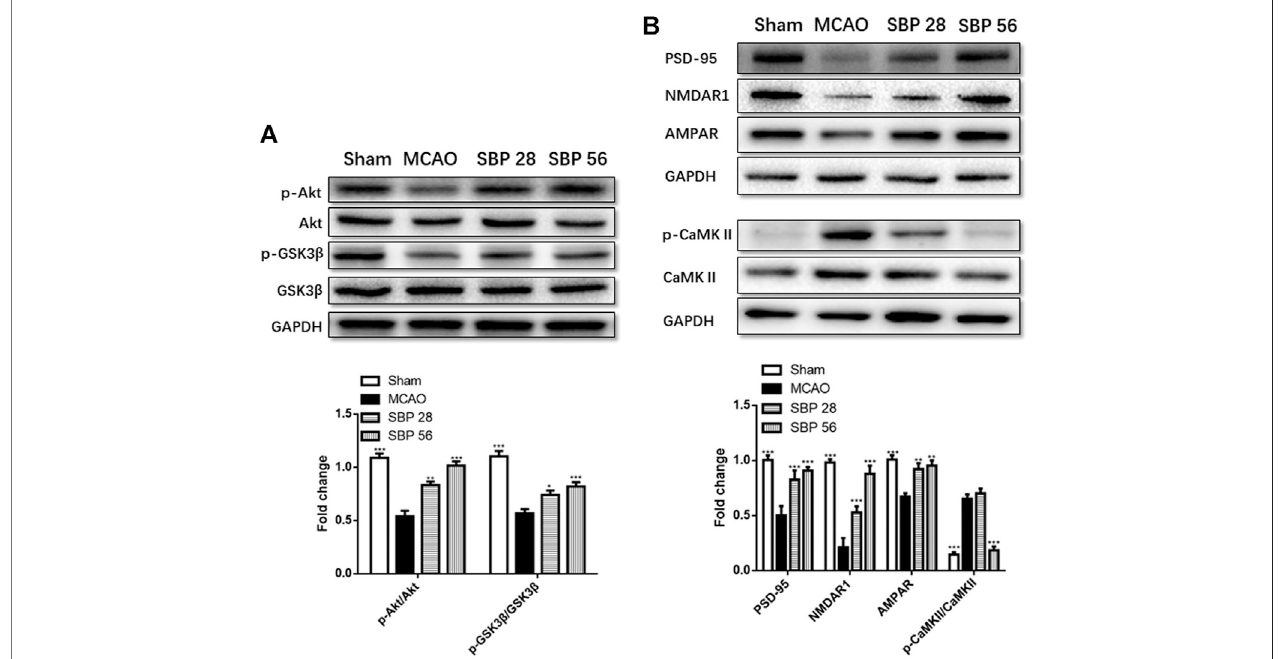
FIGURE 5 | (A) Western blot analysis of p-Akt, Akt, p-GSK3 β , and GSK3 in the ipsilateral side of the brain of rats at 14 d after MCAO (or sham surgery) operation. (B) Western blot analysis of PSD-95, NMDAR1, AMPAR, p-CaMKII, and CaMKII in the ipsilateral hippocampus of rats at 14 days after MCAO (or sham surgery) operation. Data are expressed as mean ± SEM, n (cid:2) 5; * p < 0.05, ** p < 0.01, and *** p < 0.001.